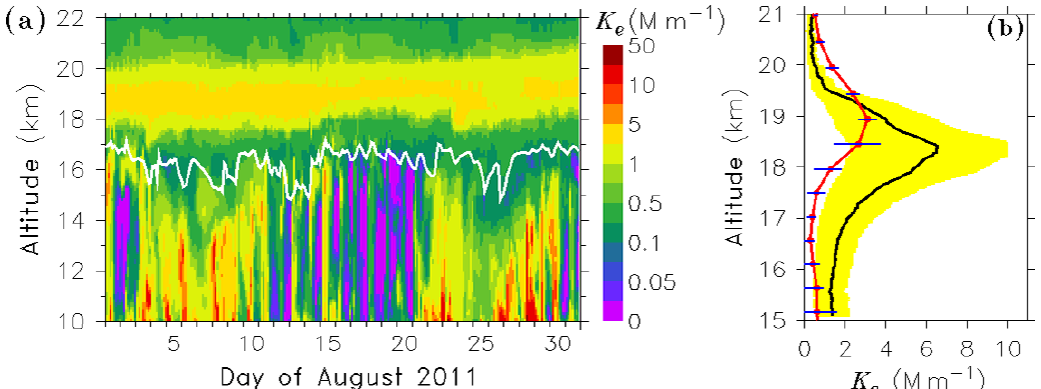
Figure 4. (a) Time series of the vertical profile of the aerosol extinction coefficient at 550nm wavelength, K e , in unit of inverse of megameter (Mm − 1 or 10 − 6 m − 1 ) over Naqu at 3h intervals in August 2011, as simulated by EMAC. Thick white line refers to the WMO tropopause altitude in unit of kma.s.l. (b) Comparison of the model-simulated vertical distribution of K e in the UTLS region with lidar measurements at Naqu. Red and blue lines refer to the monthly mean values and standard deviations derived from the model. Black line and yellow shaded area are the mean values and standard deviation ranges of measurement